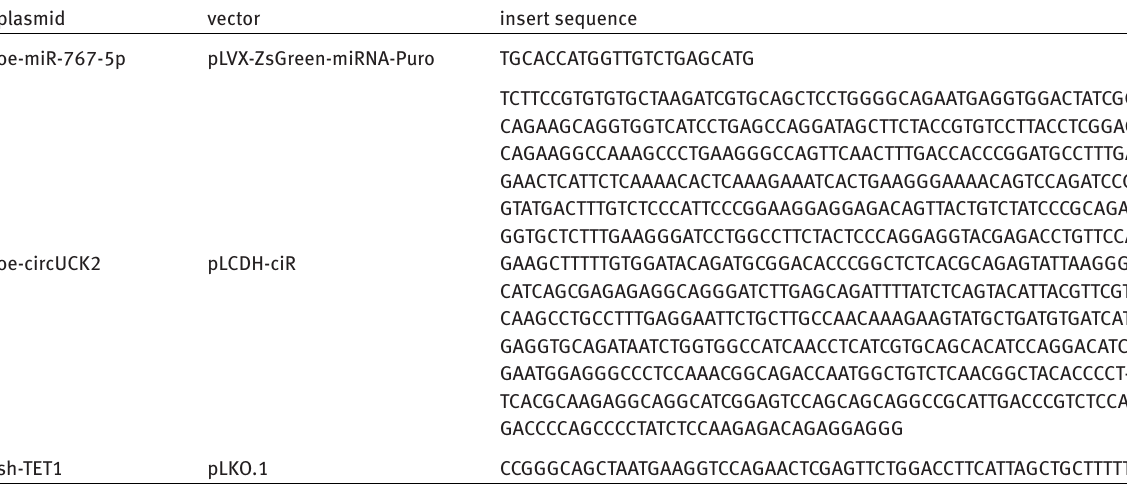
Table 2: Insertion sequence for plasmids